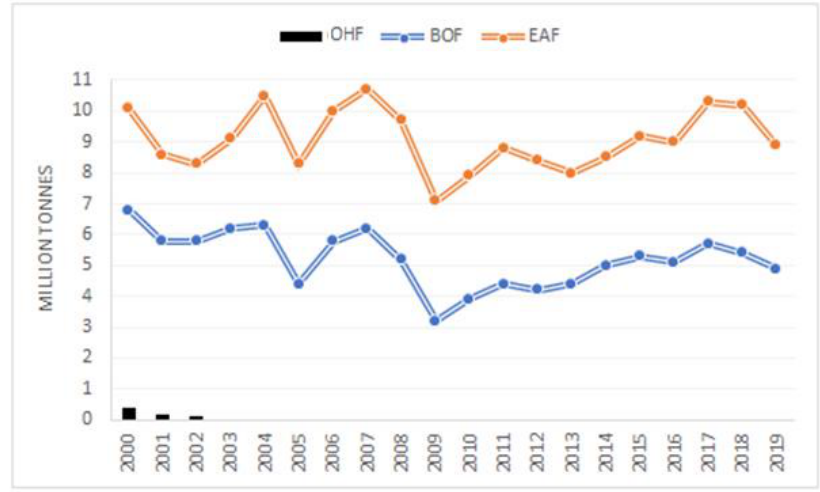
Figure 5. Trends in steel production processes in the Polish steel industry.